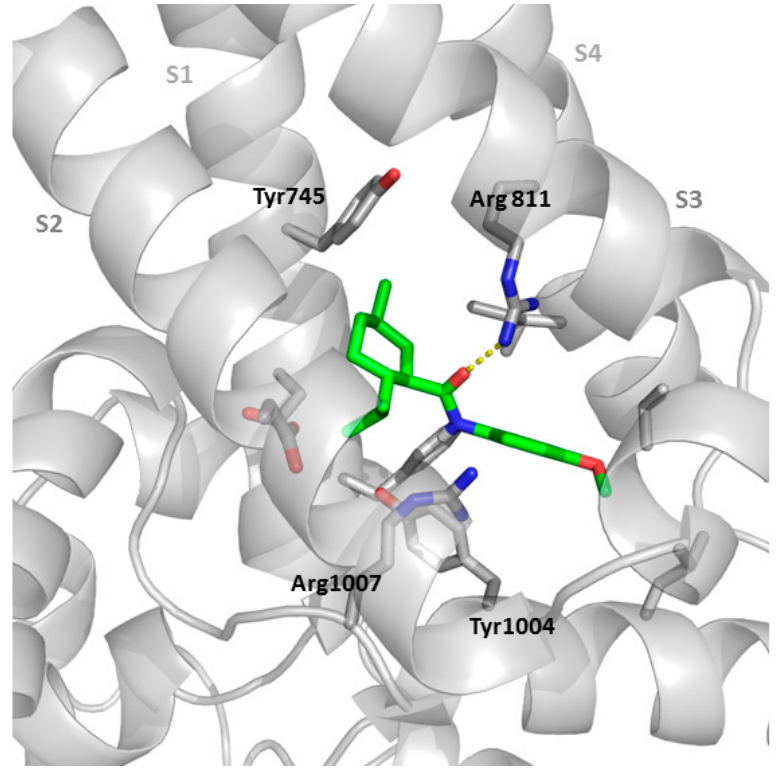
Figure 6. Partial structure of the TRPM8 (gray)/WS-12 (green) complex (generated from 6NR2, https://www.rcsb.org/structure/6NR2).